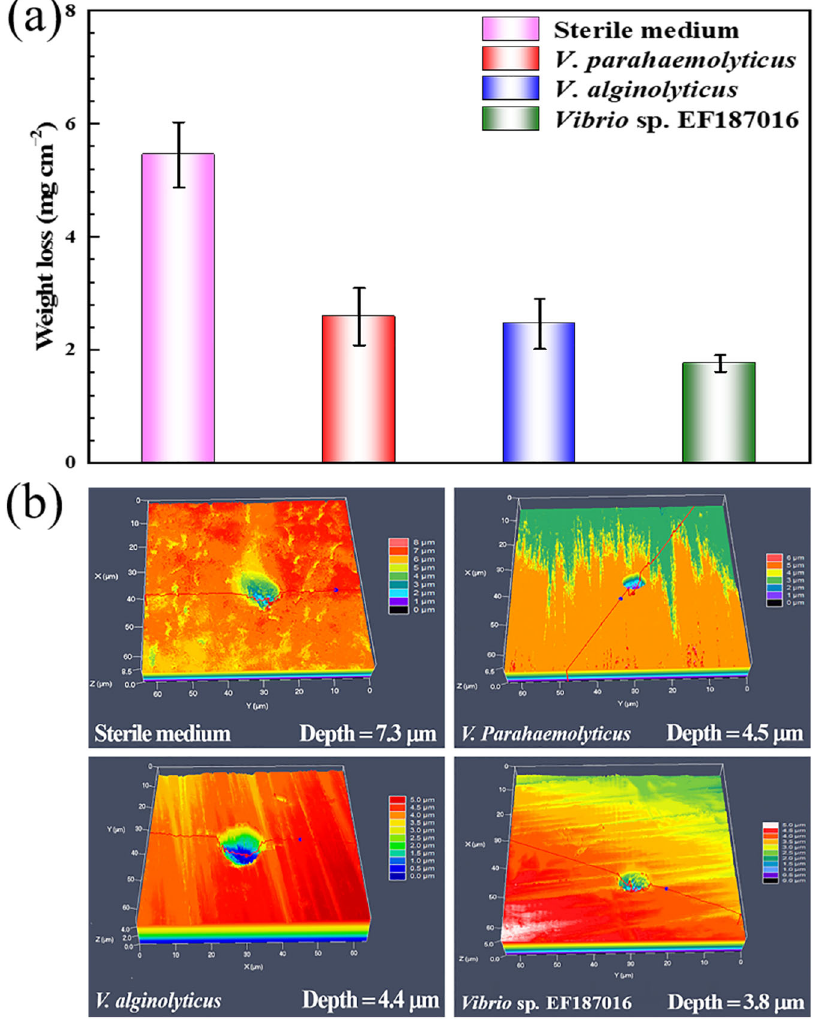
Fig. 3 Corrosion of X80 coupons. a Weight loss in different media after 14-d incubation, b maximum pit depth in different media after 14-d